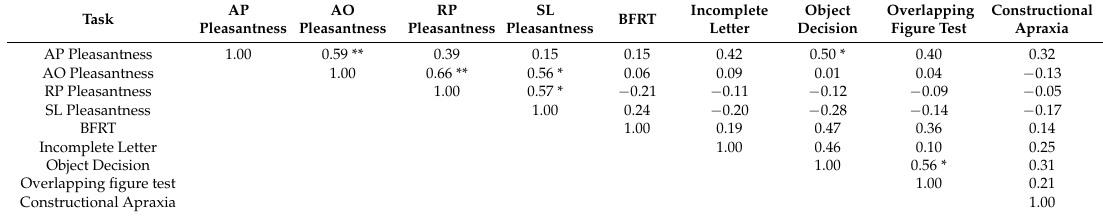
Table 2. Spearman’s correlation coefficients. Significant correlations are marked with asterisks (* p < 0.05; ** p < 0.01). Notes. BFRT = Benton Facial Recognition Test; AP = Arcimboldo’s portraits;